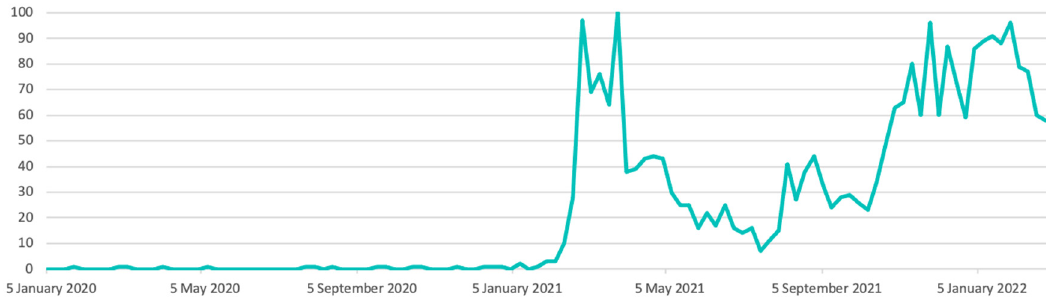
Figure 2. Worldwide searched term on Google for “NFT Music”.